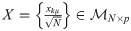
The investment risk ɛ and the concentrated investment level q
w are shown for the case in which the return rate x
kμ is independently and identically distributed with a standard normal distribution.The horizontal axis indicates the scenario ratio α = p/N, and the vertical axis shows the investment risk and the concentrated investment level q
w. The two solid lines (results obtained by our proposed approach) and the two dotted lines (results obtained by the operations research approach) are theoretical results. The markers with error bars are the numerical results evaluated using the optimal solution according to a return rate which was randomly assigned. In the simulation, the number of investment outlets N was 103, and we averaged 100 return rate matrices X={xkμN}∈𝓜N×p. This figure shows that the results obtained by our proposed approach (solid lines) and the numerical results (markers with error bars) are in agreement. On the other hand, the results obtained by the operations research approach (dotted lines) do not coincide with the others. Thus, unfortunately, the approach based on maximizing the expected utility cannot propose an optimal investment strategy.